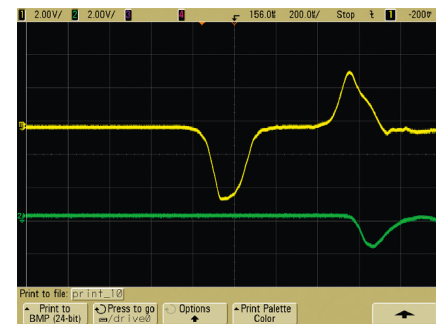
Figure 3: Original waveform in the oscilloscope.